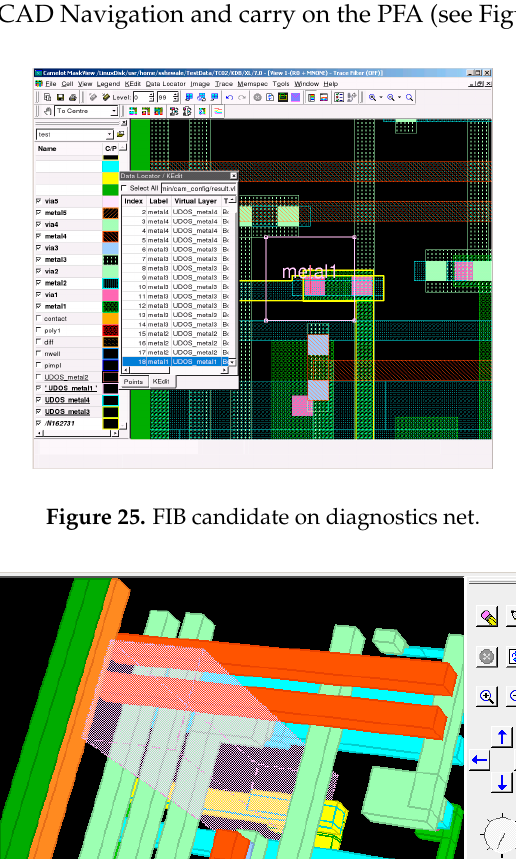
Figure 26. 3D View with FIB simulation.